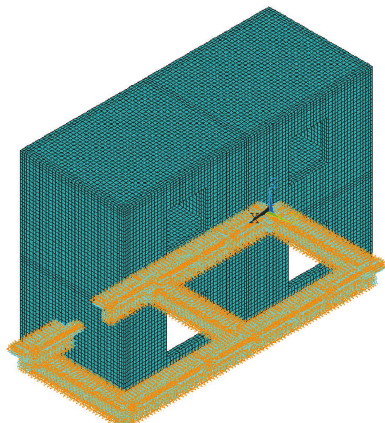
Figure 3: Arrangement of